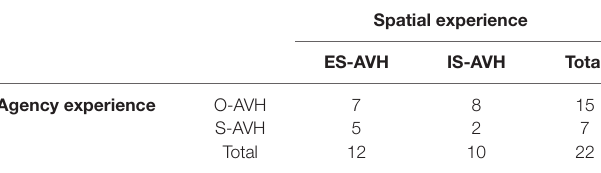
TABLE 4 | Associations between agency and spatial experiences of AVH. Chi square did not rule of the null hypothesis of no associations at a p > 0.28. Also note S-AVH are more likely to be experienced in external